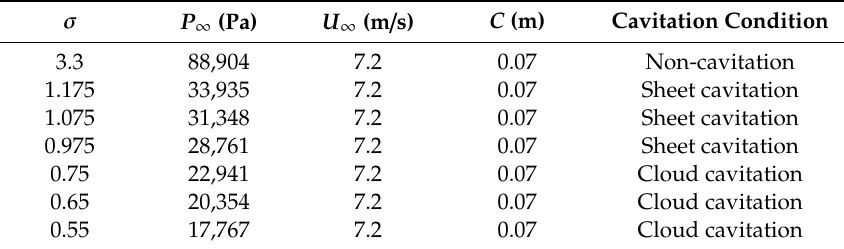
Figure 3. Mesh distribution of the computational domain.